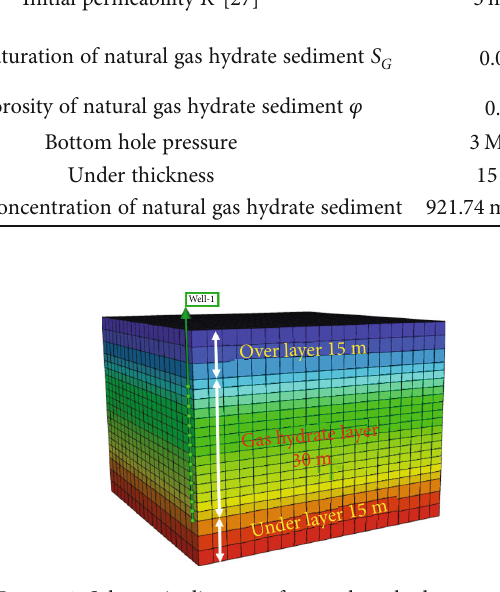
Figure 1: Schematic diagram of natural gas hydrate reservoir.